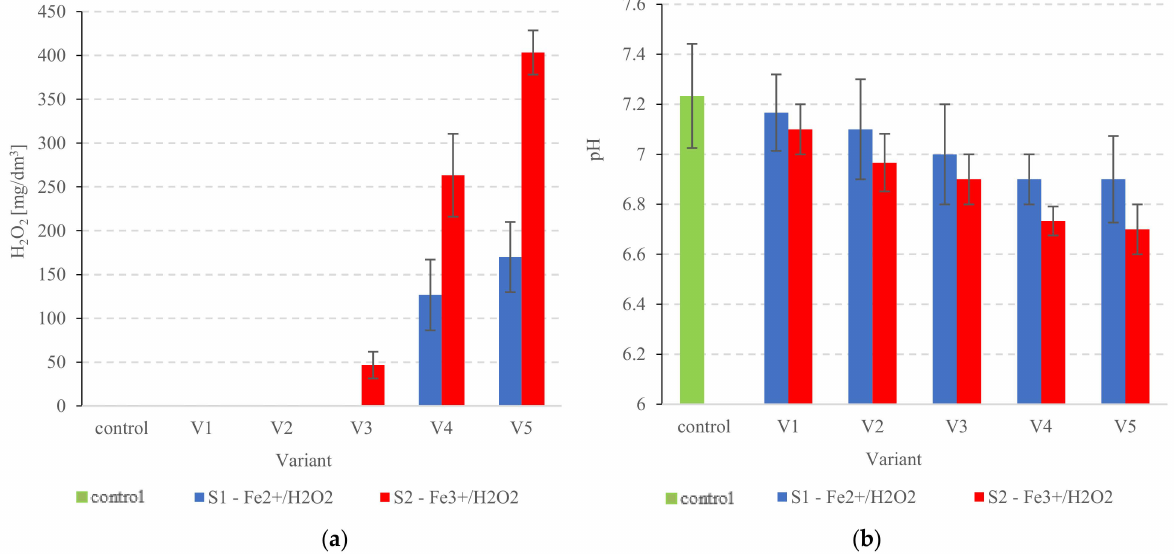
Figure 4. In the PSS after pre-treatment, ( a ) residual H 2 O 2 levels and ( b ) changes in